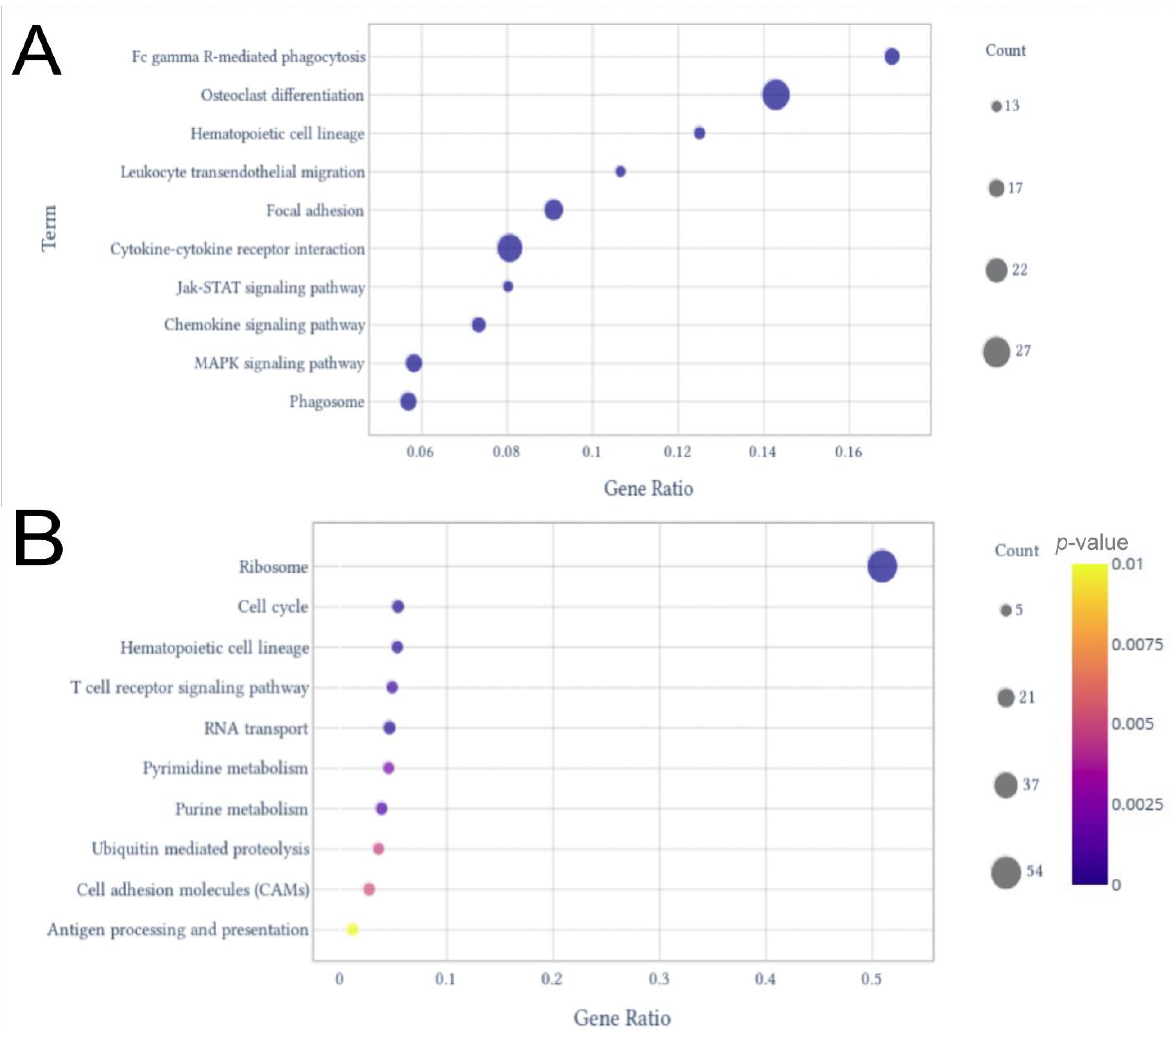
Figure 3. Dot plots from KEGG pathway enrichment analysis. The plots display the top 10 terms with higher gene counts among up-regulated genes ( A ) and down-regulated genes ( B ).